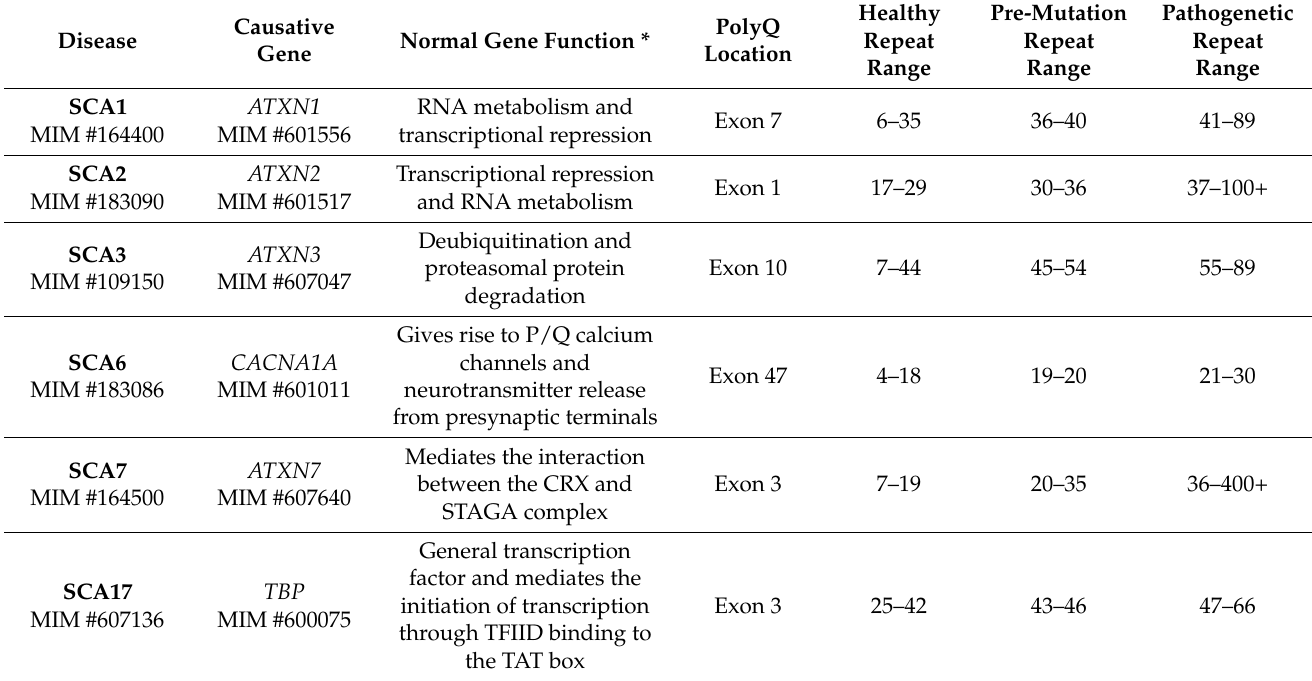
Table 1. Genetics of the polyglutamine